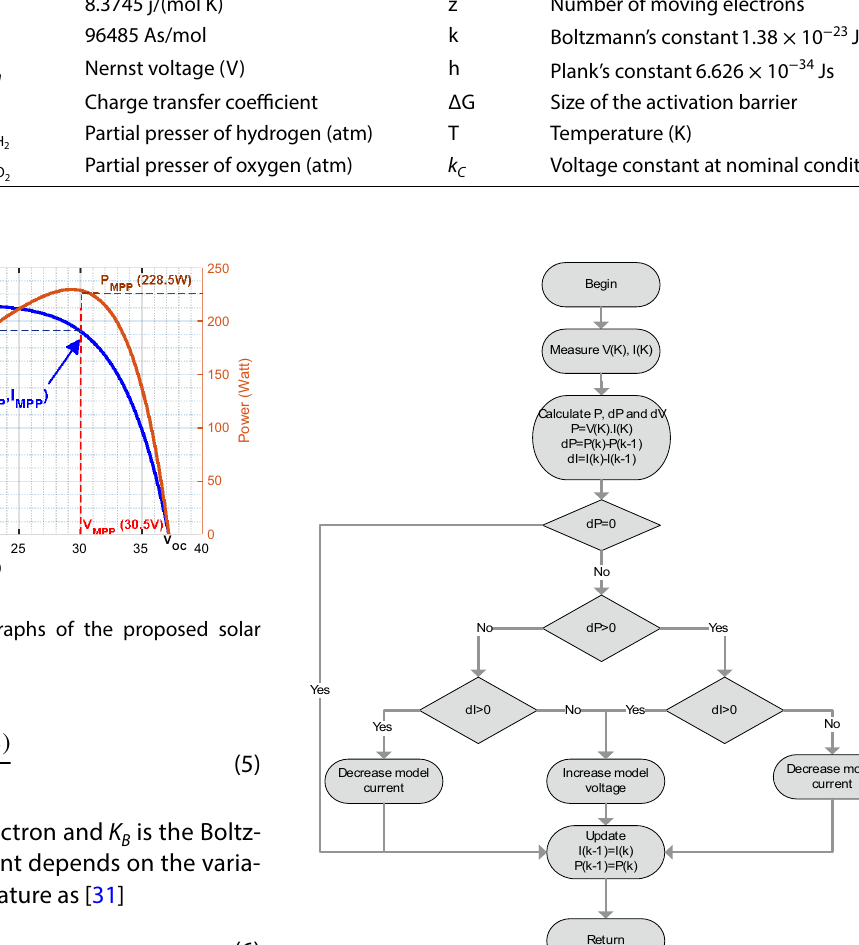
Table 1 Model parameters